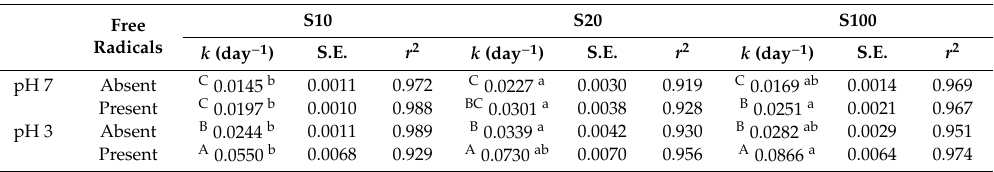
Table 2. E ff ect of pH and water-soluble free radicals on the degradation rate constant ( k ) of lycopene in emulsions containing TBHQ.